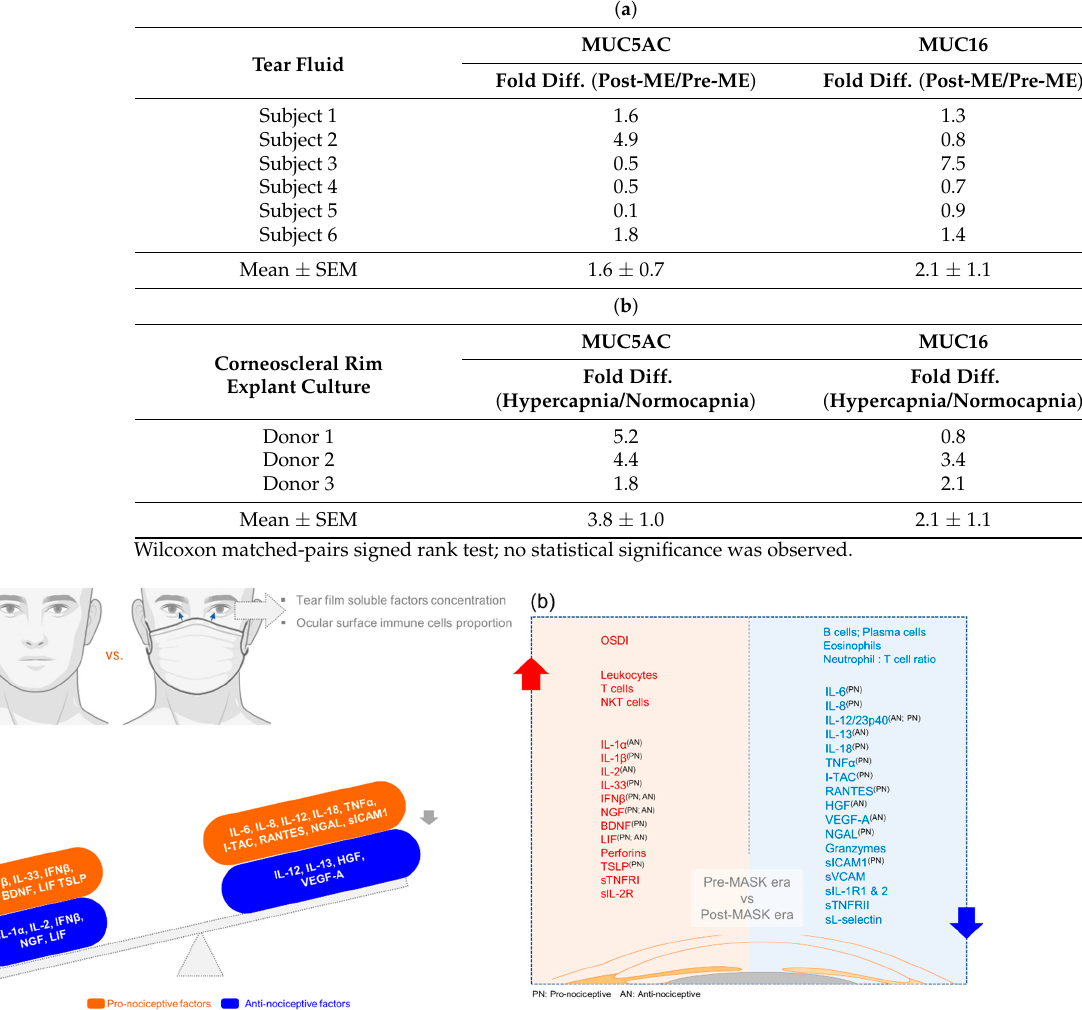
Table 3. ( a ) Status of mucin 5AC and mucin 16 in tear fluid in study subjects following mask wear and in corneoscleral explant culture following exposure to hypercapnia. ( b ) Status of mucin 5AC and mucin 16 in corneoscleral explant culture following exposure to hypercapnia.